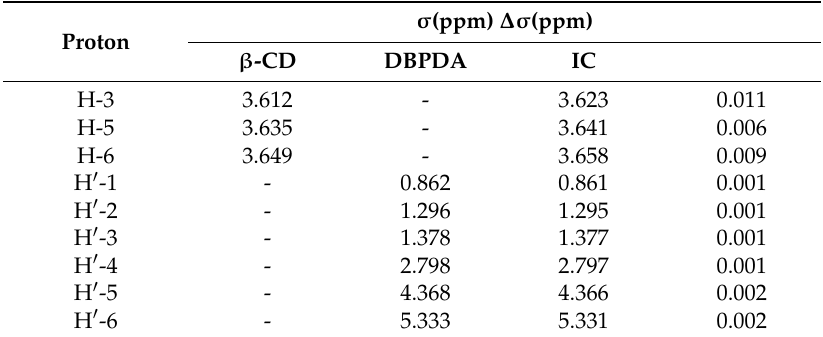
Table 1. Chemical Shift Values ( σ ) and Its Variations ( ∆ σ ) for the protons of β -CD, DBPDA in the free state and in IC.